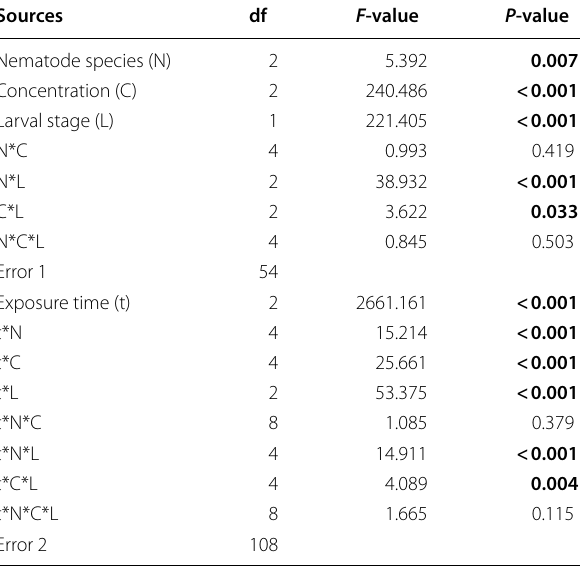
Bold numbers indicate statistical significance at level alpha